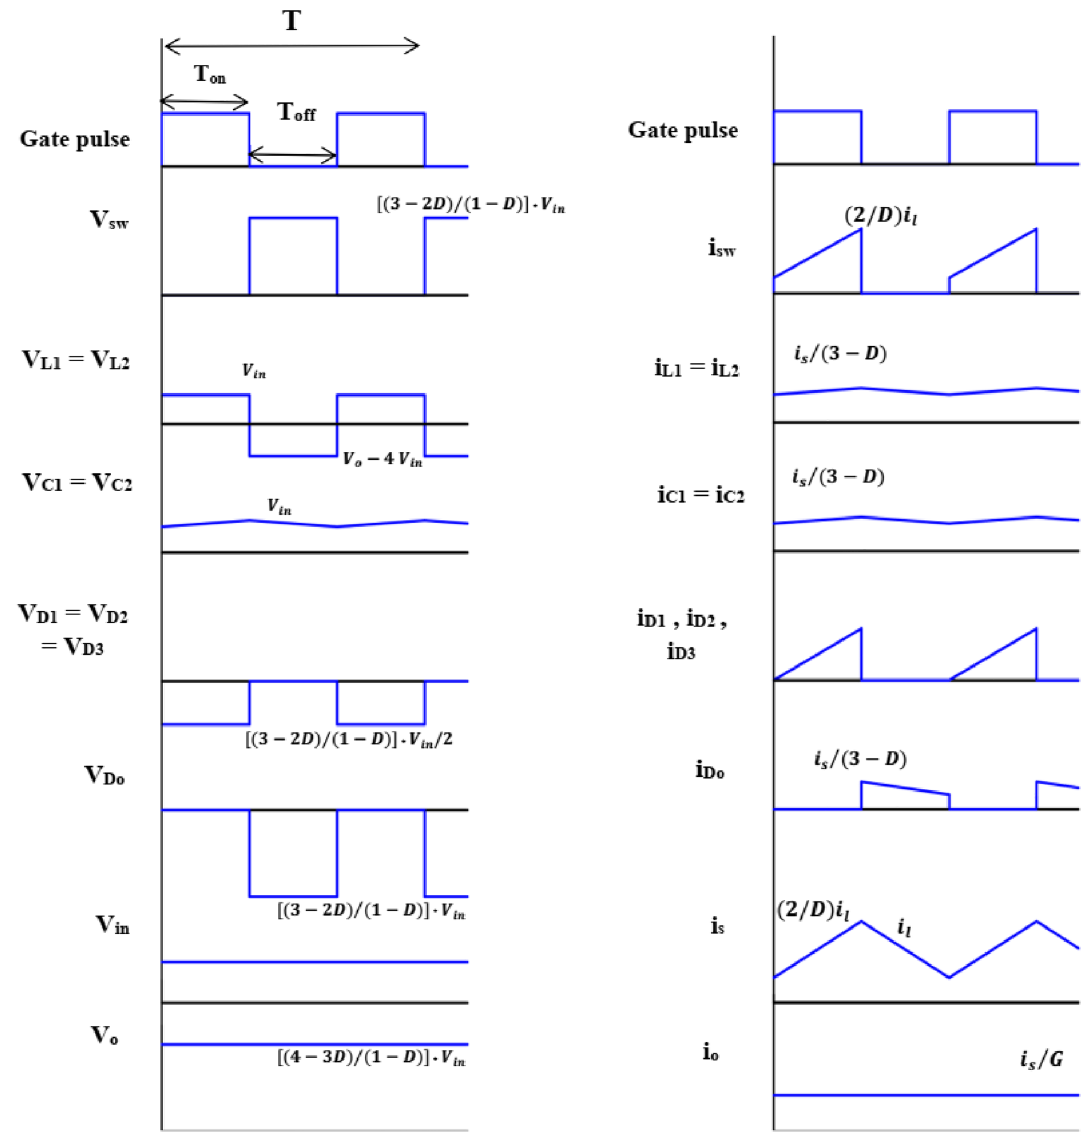
Figure 3. Operating modes of proposed converter.